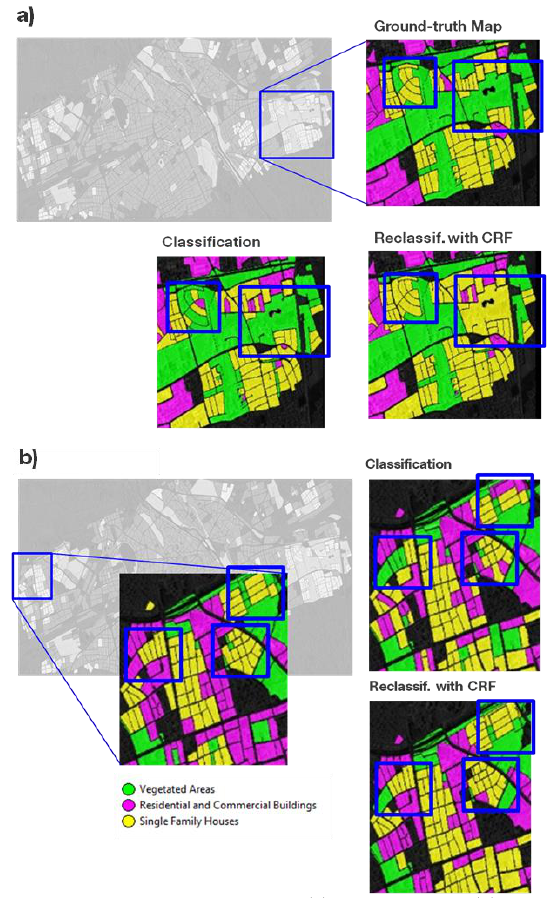
Figure 6. Examples of erroneous (a) and successful (b) class changes performed by the CRFs-based reclassification